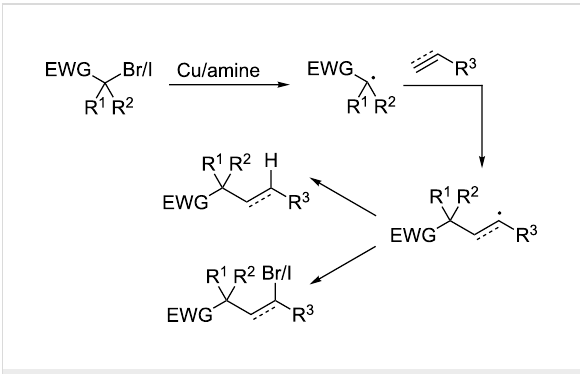
Scheme 8: Copper-catalyzed alkenylation